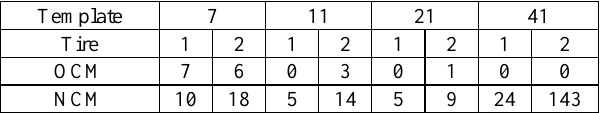
Figure 7. Matching points (Tire1)